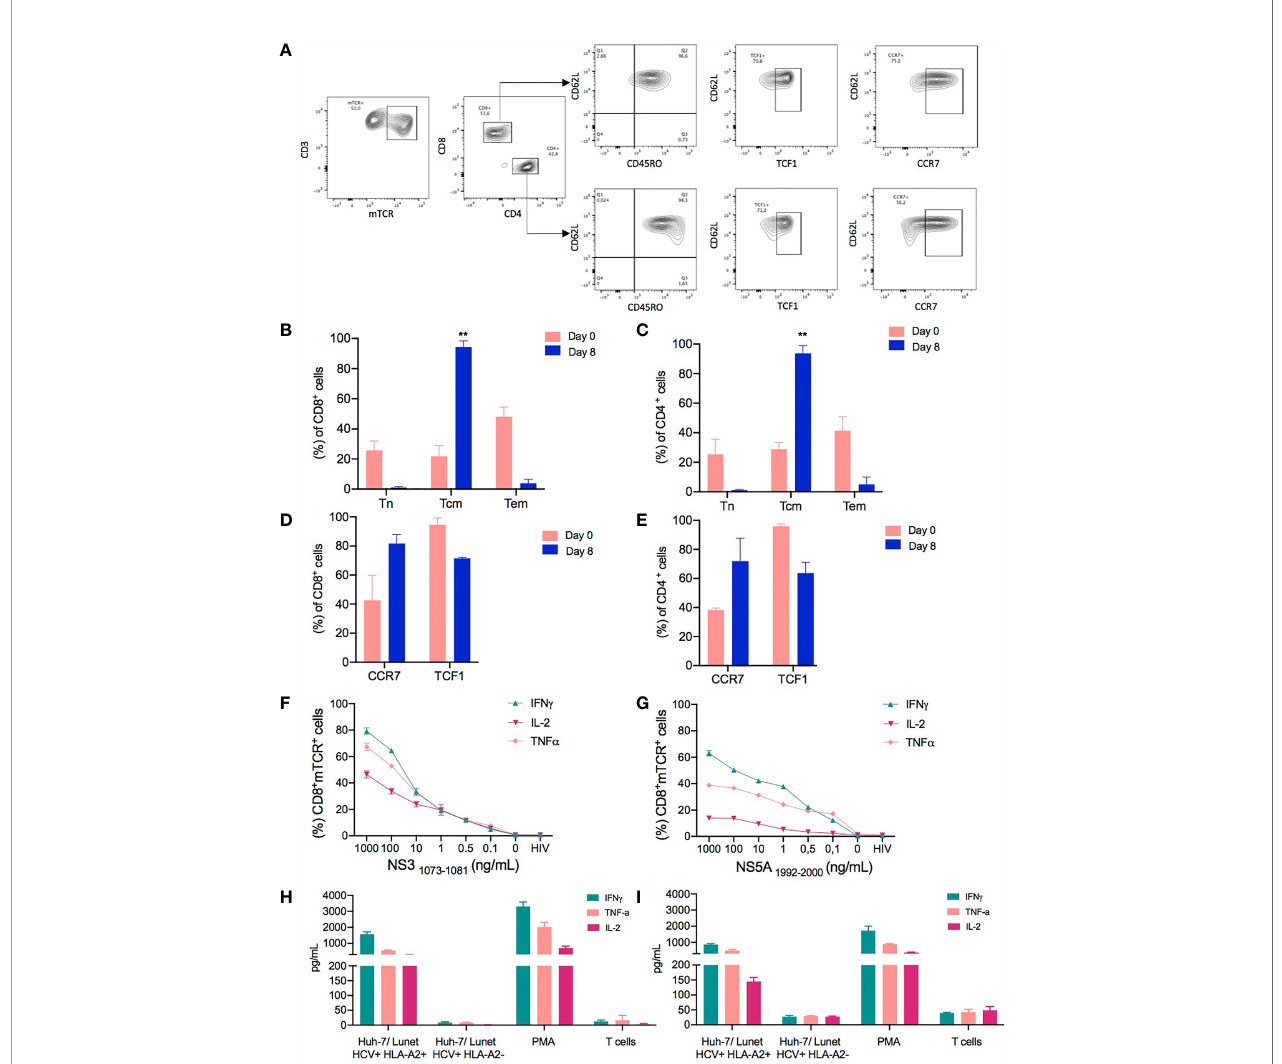
FIGURE 4 | Phenotype and functionality of T cell receptor (TCR)-T cells produced in a large scale. The phenotypic characteristics of cells expanded in the CliniMACS Prodigy was assessed by fl ow cytometry to identify the percentage of memory T cell markers in TCR-T cells. (A) Representative FACS plots showing the gating strategy for the evaluation of memory T cell populations. The memory T cell populations were analyzed by gating on live lymphocytes based on their FSC-A/SSC-A pro fi le and excluding any doublets. Subsequently, CD4+ and CD8+ mTCR+ transduced cells were analyzed in regard to their T cell subpopulations as assessed by the expression of CD45RO and CD62L. Besides the Tcm subpopulation (CD62L+ CD45RO+), the CCR7 and TCF1 expressions were evaluated in the CD62L+ population. The subpopulations were de fi ned as follows: naïve T cells, CD62L+CD45RO-; central memory T cells (Tcm), CD45RO+CD62L+; and effector memory T cells (Tem), CD62-CD45RO+. (B, C) Column graphs showing the relative frequencies of the indicated subpopulations in CD8+ (B) and CD4+ T cell subsets (C) for each time point analyzed (days 0 and 8). (D, E) Comparison of CCR7 and TCF1 expressions evaluated on cells from the starting material (day 0) and expanded transduced T cells on day 8. (F, G) Hepatitis C virus (HCV)-speci fi c responses as assessed by fl ow cytometry analysis for the intracellular content of IFN g , TNF a , and IL-2 in CD8+ transduced T cells following 6 h of coculture of NS3 1073 – 1081 or NS5 1992 – fi c TCR-T cells manufactured in CliniMacs Prodigy. HIV peptide-loaded T2 cells and non-stimulated T cells 2000 peptide-loaded T2 cells with the indicated NS3- or NS5-speci were included as negative controls in the coculture experiments performed in triplicate wells. (H, I) Cytokine production of TCR-T cells when cocultured with Huh-7/Lunet HCV replicon target cells as measured by Milliplex map human high-sensitivity kit. Huh-7/Lunet HCV replicon cells that were not engineered to express HLA-A2 (Lunet HCV+/HLA- A2-) as well as non-stimulated T cells were used as negative controls in the experiments performed with technical triplicates. The results are shown as mean ± SD for three independent healthy donors. ** is p value ≤